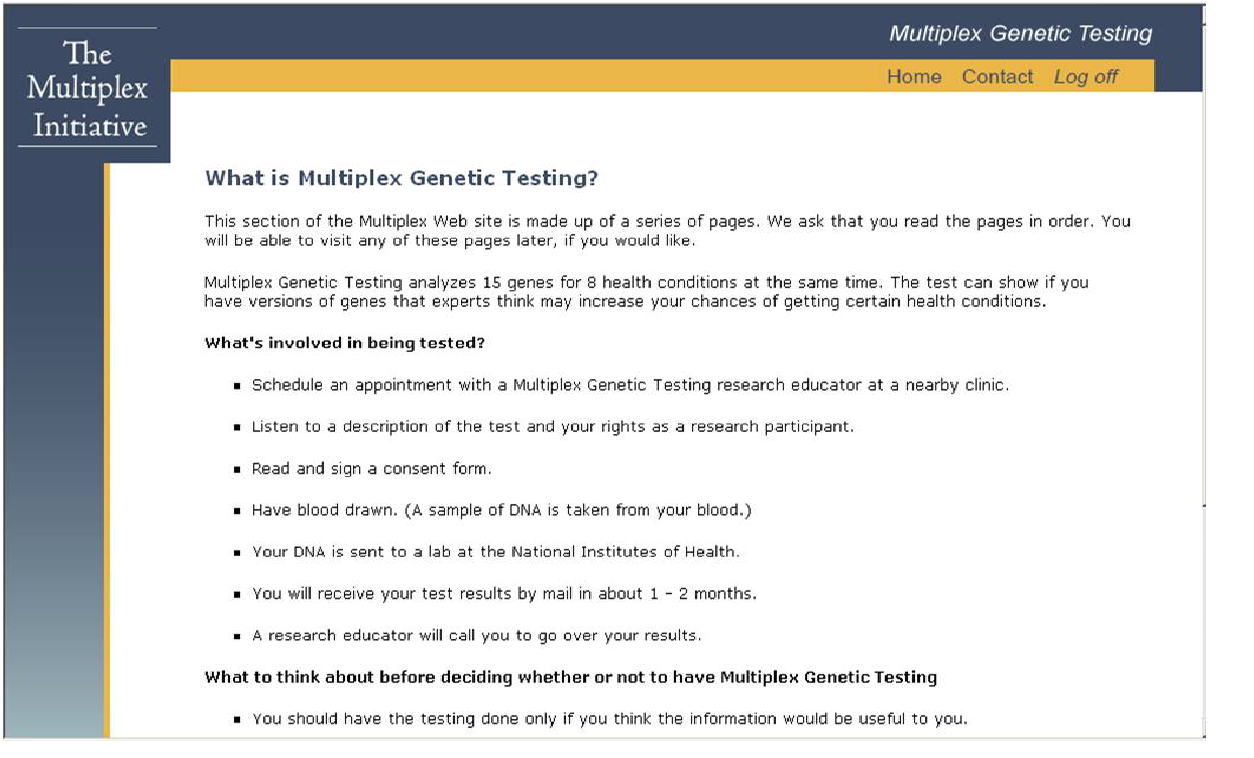
Figure 1. Example website page providing information about Multiplex Genetic Testing